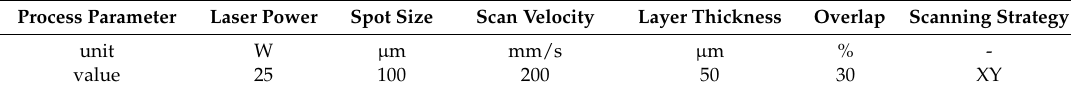
Table 1. Process parameters used to manufacture test specimens